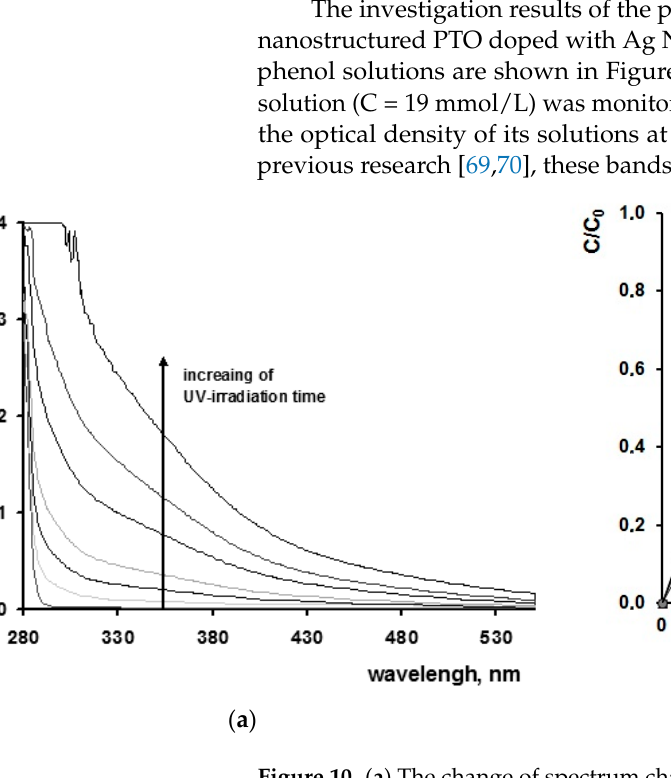
Figure 10. ( a ) The change of spectrum character of phenol aqueous solution under UV irradiation in the presence of nanocomposites (C = 19 mmol/L); ( b ) relative optical density dependence of phenol solution at 400 nm under UV irradiation in the presence of nanocomposites: curve 1—«empty» experiment, curve 2—BMA + Ag NPs, curve 3—HEMA + Ag NPs, curve 4—AN + Ag NPs.